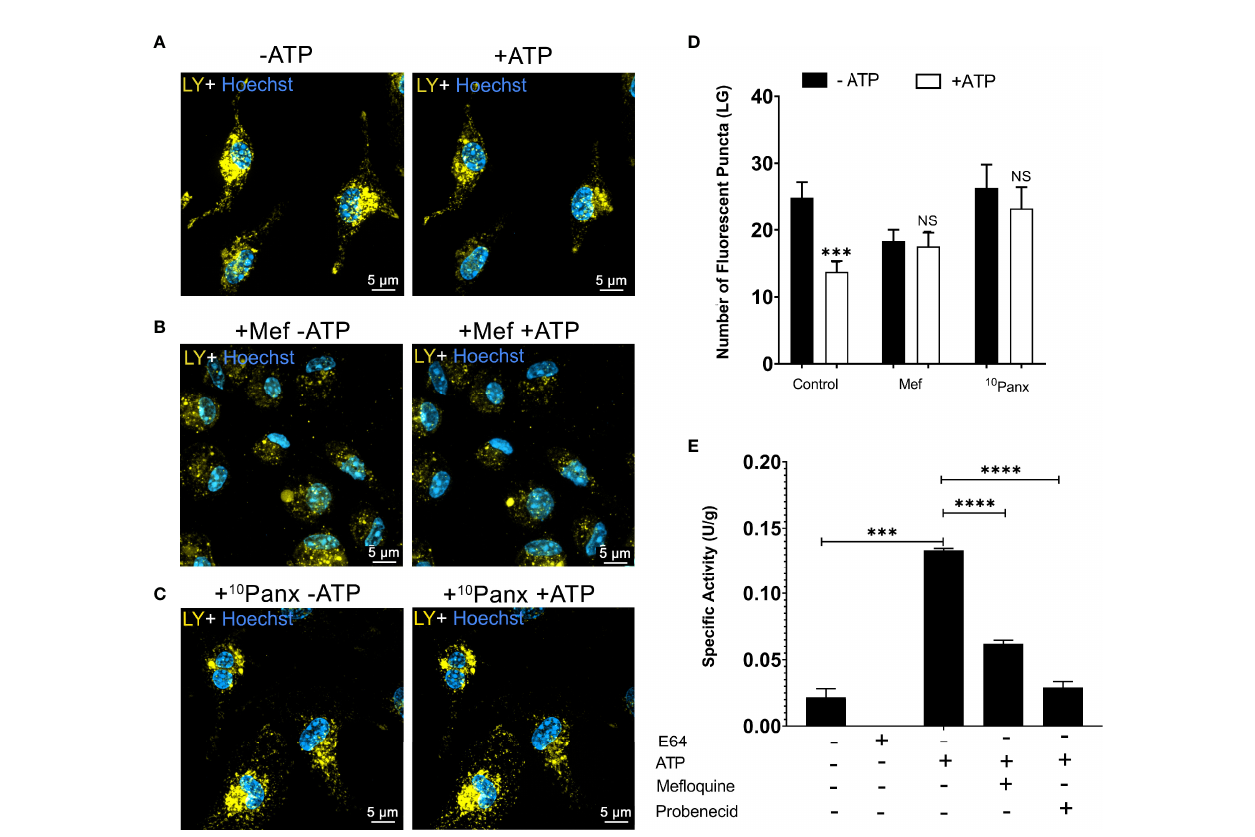
FIGURE 3 | Pannexin-1 Contributes to P2X7-Induced Lysosome/Endolysosome Rupture. Representative images of WT peritoneal macrophages labeled with 1 mM of Lucifer Yellow (LY) for 45 min, (A) without treatment with inhibitors, (B) WT macrophages pre-incubated with 100 µM me fl oquine for 30 minutes, and (C) WT macrophages incubated with 20 µM 10 Panx for 30 minutes; before and after treatment with 5 mM ATP. (D) The number of fl uorescent puncta stained with Lucifer Yellow was counted before and after ATP treatment. (E) Cathepsin activity in the supernatants of cells pretreated with me fl oquine, probenecid, and then treated or not with 5 mM ATP for 10 min. Scale bar, 5 µM; original magni fi cation 100x. Data are expressed as mean ± SEM of three independent experiments performed in triplicates and analyzed using one-way analysis of variance ***P < 0.001 and ****P < 0.0001. Analysis of conditions without ATP vs treatment with 5 mM ATP (D) . Analysis of conditions without ATP vs treatment with 5 mM ATP and treatment with 5 mM ATP vs me fl oquine and probenecid (E) . NS, not signi fi